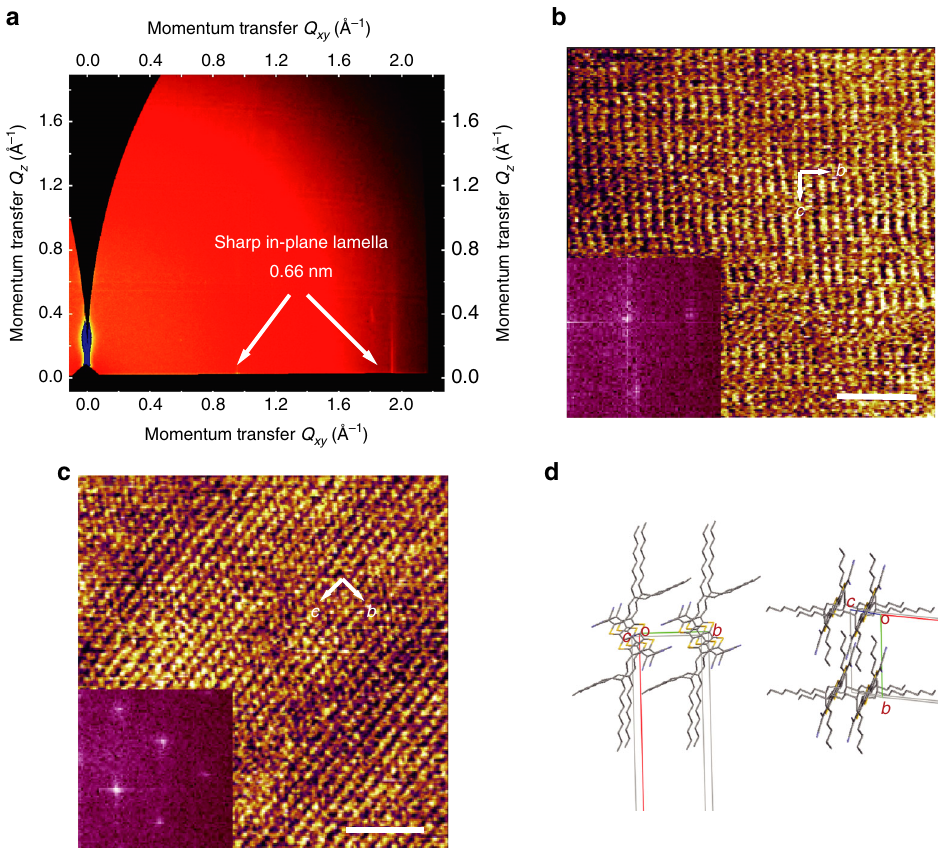
Fig. 2 Structural characterizations of the monolayer of CMUT on SiO 2 /Si ++ . a The GIWAXS pattern of the monolayer. b , c HR-AFM image of the monolayer, here the scale bar is 5 nm, b top side ( b = 8.3 Å, c = 6.5 Å, θ = 90°) and c bottom side ( b = 8.4 Å, c = 6.5 Å, θ = 91°). d Monolayer crystal structure obtained by full optimization at the DFT-D3 level ( b = 9.9 Å, c = 5 Å, θ =